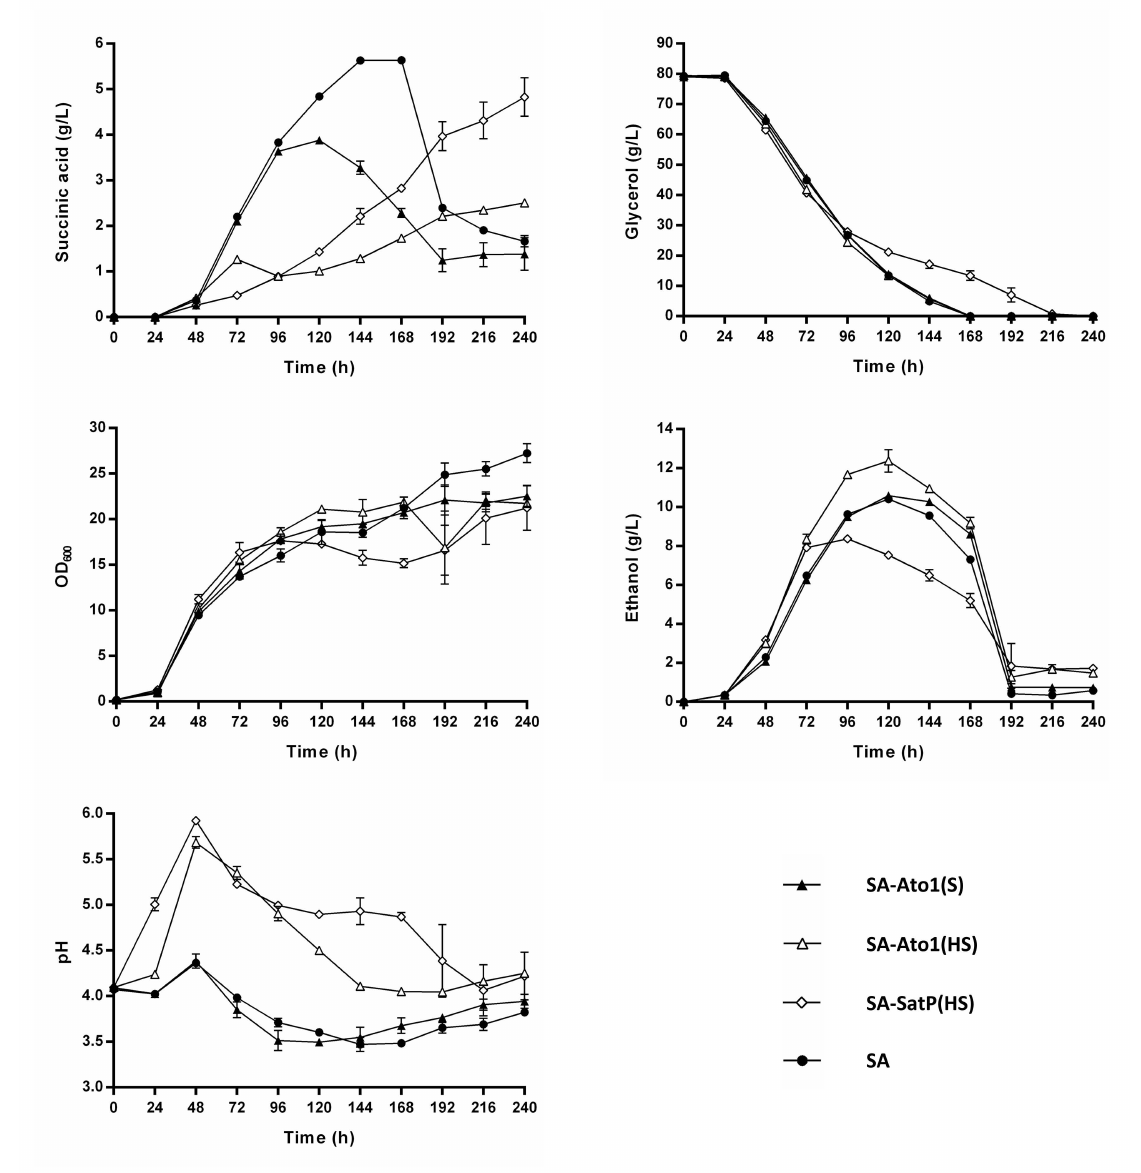
Figure 3. Saccharomyces cerevisiae strains SA-Ato1 (S) ( (cid:78) ), SA-Ato1 (HS) ( (cid:52) ), SA-SatP (HS) (